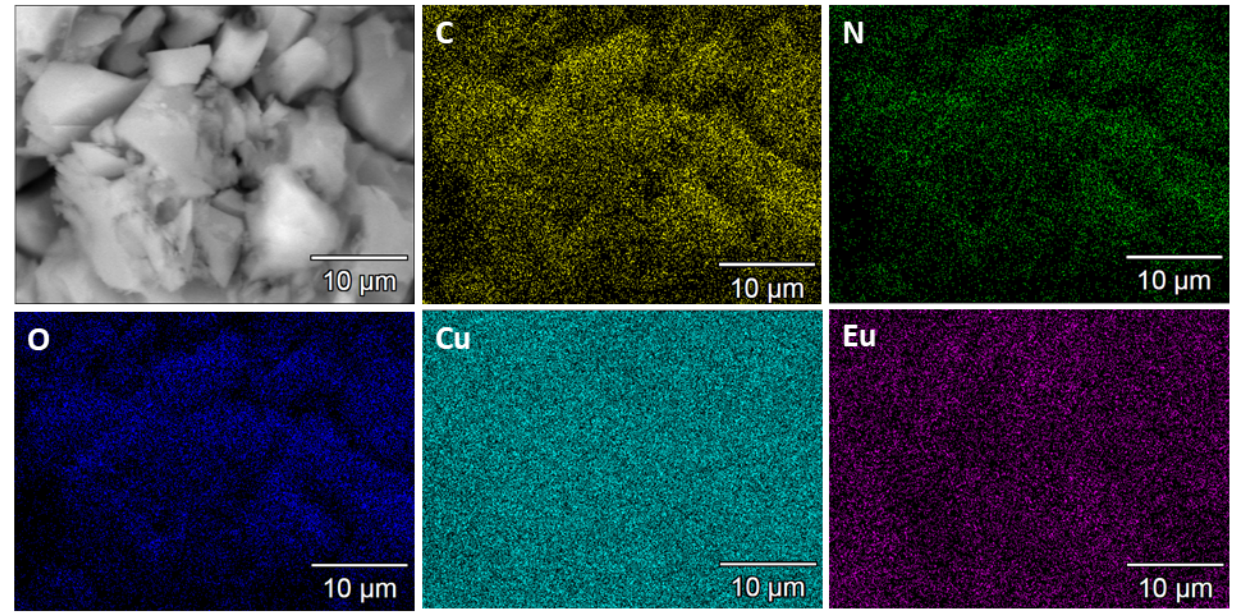
Figure 2. STEM-EDS mapping of C, N, O, Cu, and Eu for Eu@Cu-MOF.